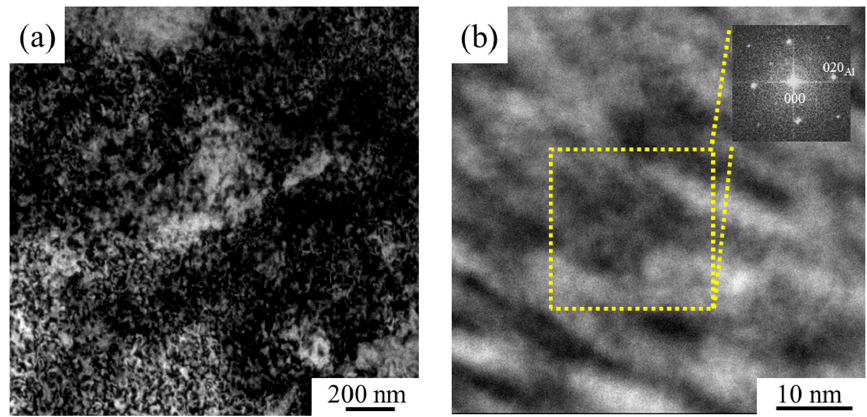
Figure 7. Microstructure of TiB 2 /2024 composites after cold rolling: ( a ) BF TEM image and ( b ) high- Microstructure of TiB 2 / 2024 composites after cold rolling: ( a ) BF TEM image and resolution TEM (HRTEM) image. Inset in ( b ) is the corresponding fast Fourier transform (FFT) pattern recorded along <0 0 1> Al . pattern recorded along < 0 0 1 > Al